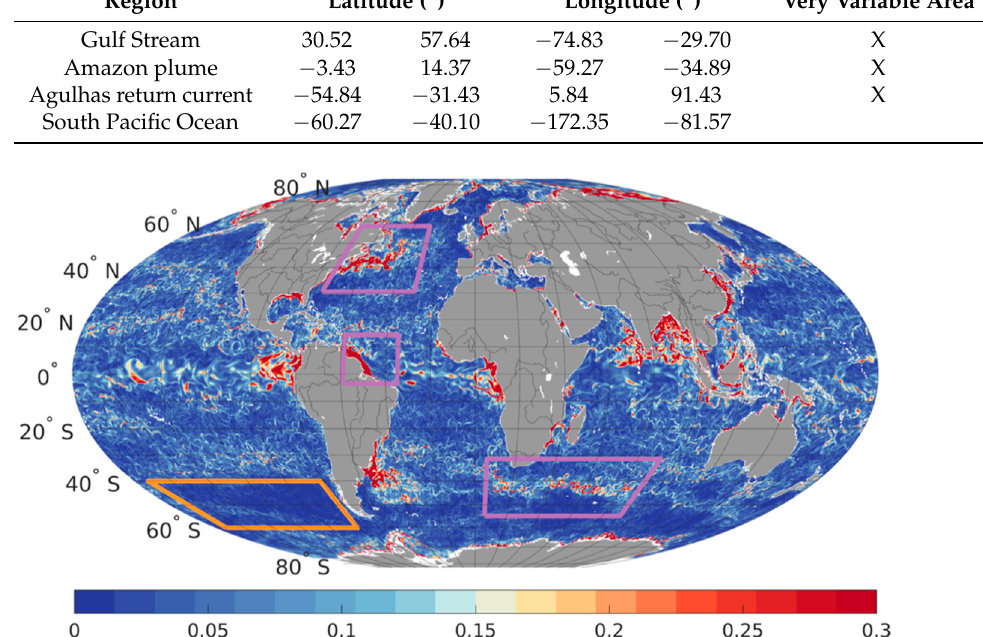
Figure 2. Standard deviation of GLORYS data within one week and 50 × 50 km 2 surface (U mis_glo ) at 5 m depth for the 15 February 2017. Orange (purple) boxes correspond to the low (high) variability regions that are selected for our tests (see regions definition in Table 1). Table 1. Definition of regions shown on Figure 2.